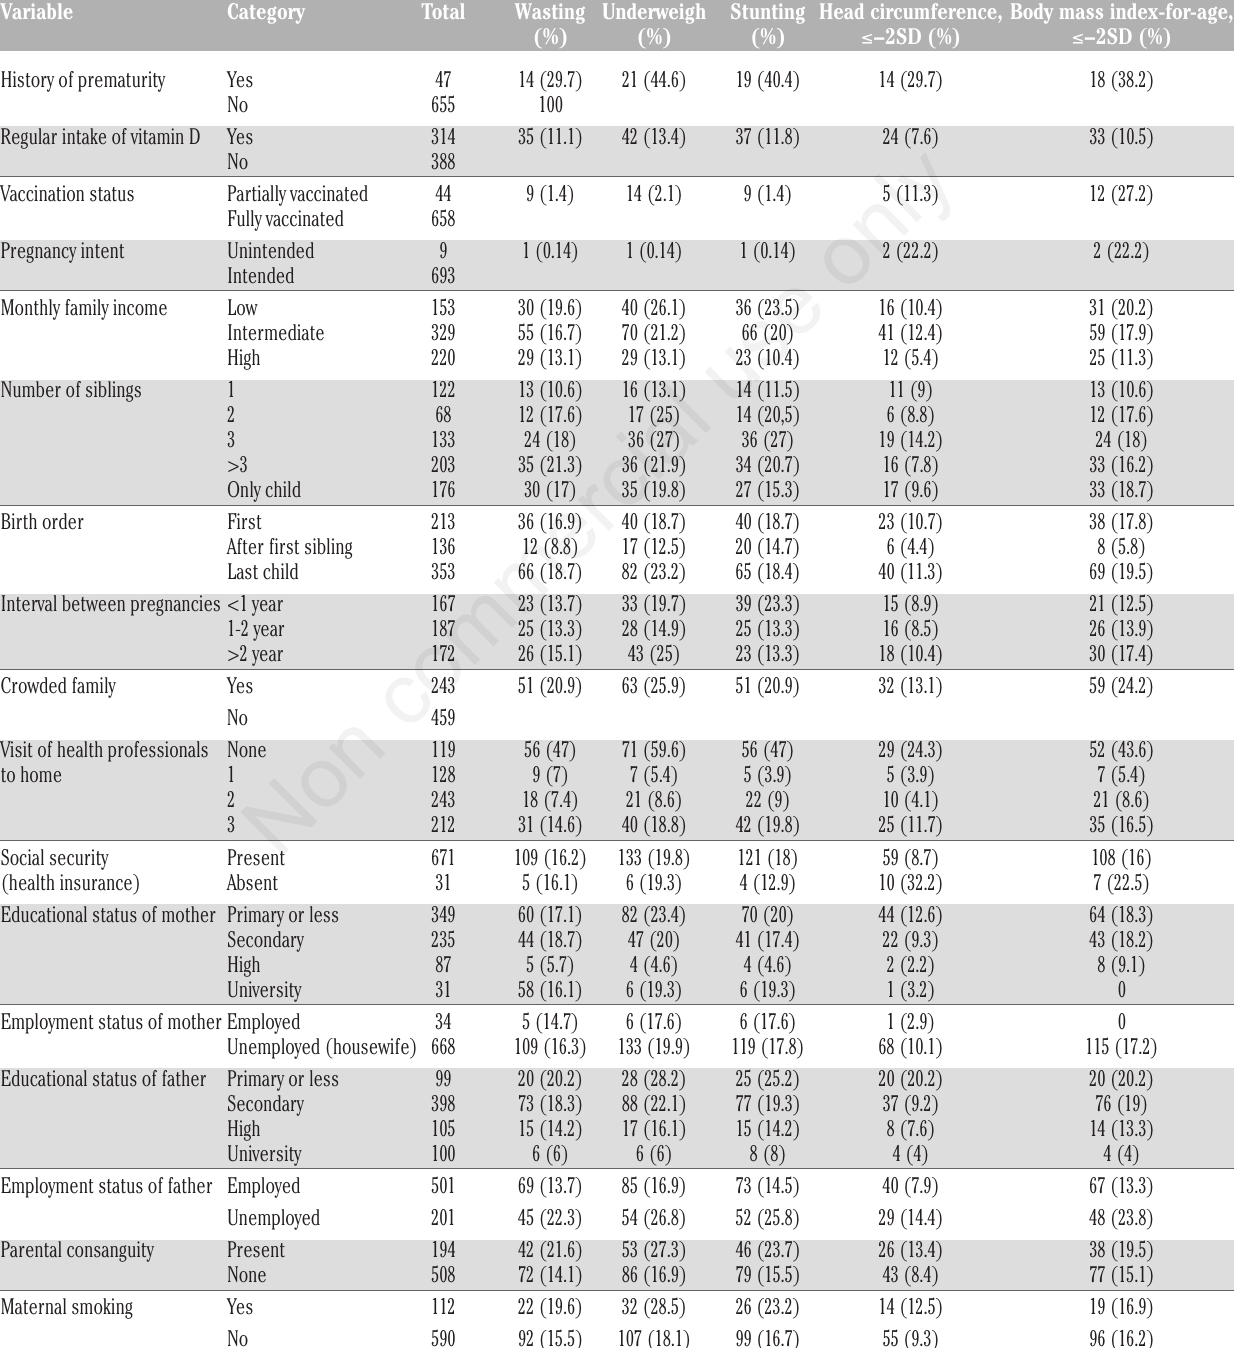
Table 2. Prevalence of wasting, underweight, stunting, head circumference under −2SD and body mass index-for-age under −2SD according to various socio demographic factors among the study